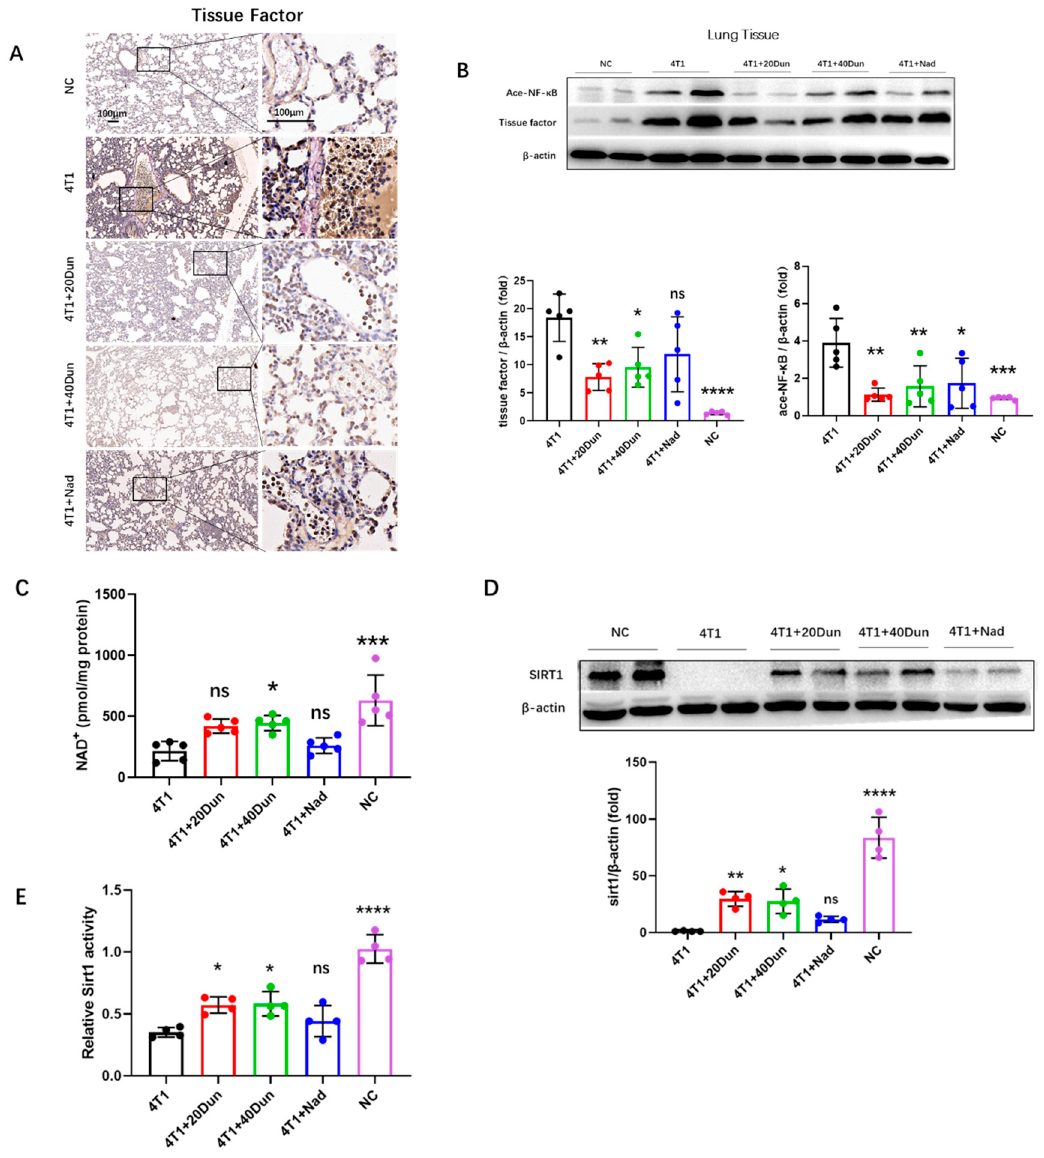
Figure 4. Dunnione attenuates breast cancer-associated lung thrombosis via the NAD(P)H quinone oxidoreductase 1 (NQO1) − nicotinamide adenine dinucleotide (NAD) − sirtuin 1 (SIRT1) − nuclear factor − kappa B (NF-kB) − tissue factor axis in vivo. ( A ) Representative IHC images for tissue factor staining of the lung sections in each group. Scale bar, 100 µ m. ( B , D ) Western blotting analysis of acetyl-NF- κ B, tissue factor ( B ), and SIRT1 ( D ) expression in lung tissues ( n = 4 for SIRT1, others 5 per group). Densitometric analysis is presented as the fold induction of the target protein relative to β -actin. ( C ) NAD + levels in lung tissues were assessed by using the NAD + /NADH assay kit in the mice of each group ( n = 5 per group). ( E ) SIRT1 activity in lung tissues was measured using the SIRT1 activity assay kit ( n = 4 per group). Data represent the mean ± SD. p -values were obtained by one-way ANOVA. Significance as compared to the samples of the 4T1 group. ns, not significant; * p < 0.05; ** p < 0.01; *** p < 0.001; **** p < 0.0001.